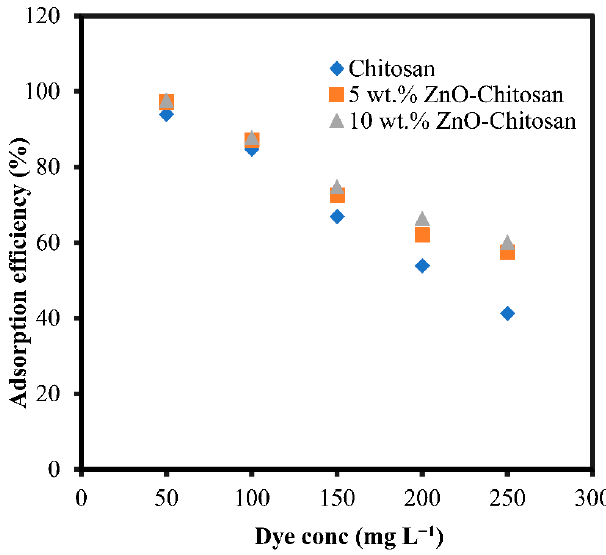
Figure 6. Effect of initial dye concentrations for the dye adsorption onto the chitosan and